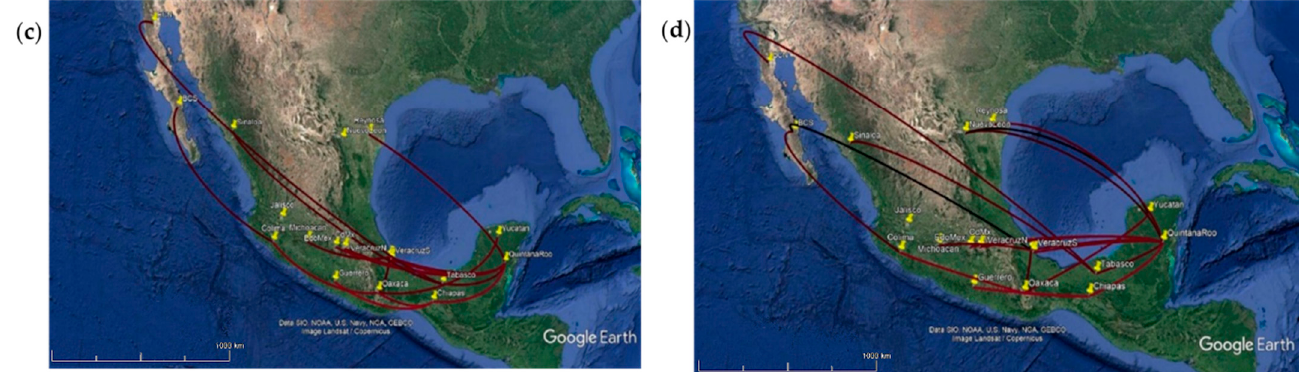
Figure 3. Spatiotemporal circulation of CHIKV during the outbreak 2014–2016 in Mexico represented with snapshots of the dispersal pattern for ( a ) December 2014, ( b ) June 2015, ( c ) December 2015 and ( d ) September 2016. Lines represent MCC phylogeny branches projected on the surface.